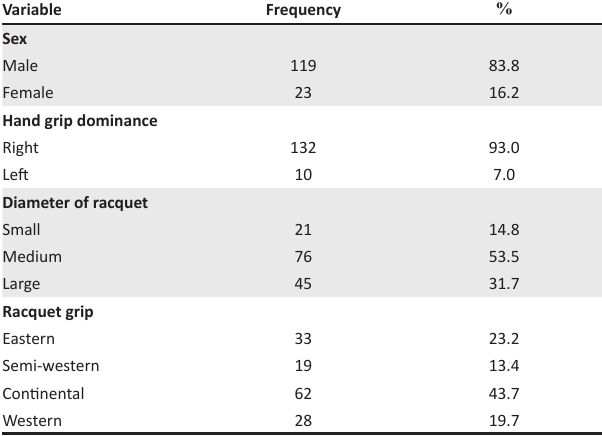
TAB LE 1: Demographics and characteristics ( n =